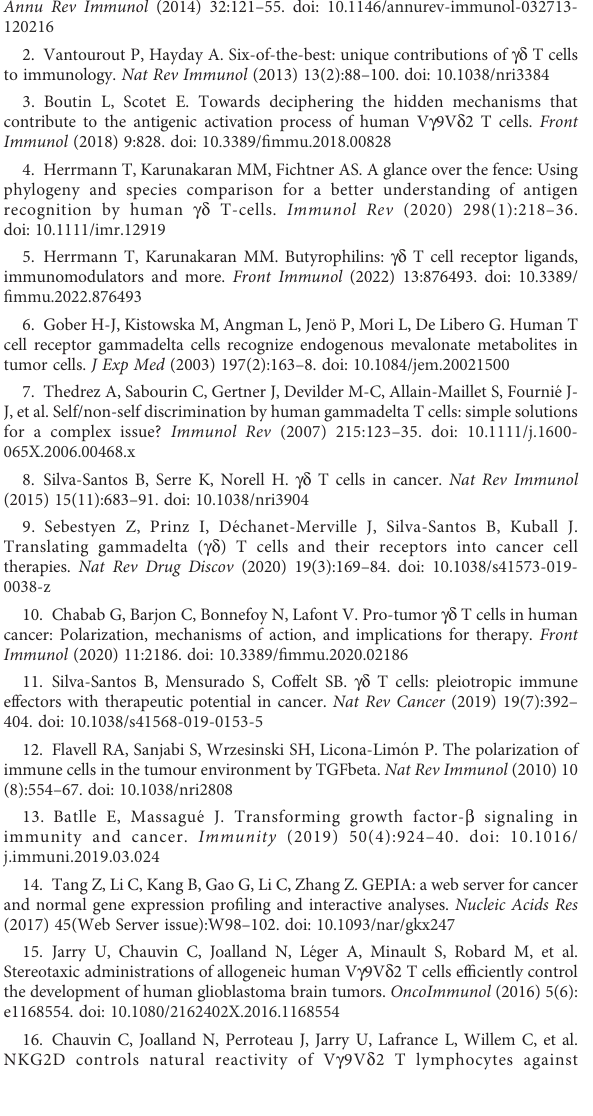
histogram ) V d 2 + T cells. Negative control, gray histogram . Percentage values are indicated in the quadrants. SUPPLEMENTARY FIGURE 2 (A) Normalized expression of NKG2D measured by fl ow cytometry at the surface of human V g 9V d 2 T cells incubated for 3 days with indicated increasing doses of recombinant human TGF- b . (B) Kinetics of expression of NKG2D expressed at the surface of human V g 9V d 2 T cells at different time-points,followingadditionofTGF- b (10ng/mL).Cellsurfacestainings were measured by fl ow cytometry. (C) NKG2D expression at the surface of human V g 9V d 2 T cells incubated with recombinant human TGF- b (10 ng/mL) at the indicated time-points (ctrl, negative control). NKG2D expression levels were next measured and normalized, at the